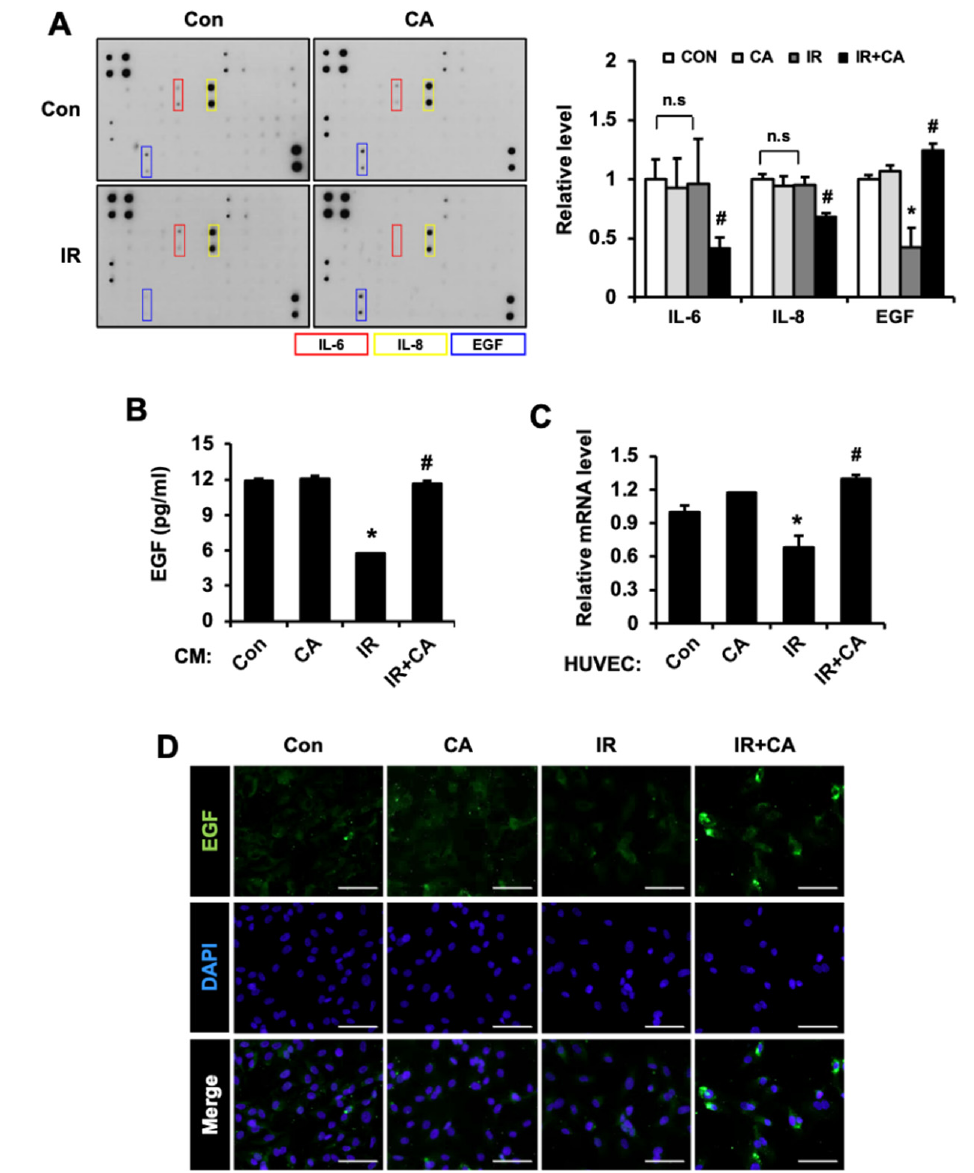
Figure 4. Centella asiatica accelerates epidermal growth factor production in irradiated endothelial cells. ( A ) The cytokine array was performed using the conditioned media of control (Con), irradiated (IR), CA-treated HUVECs (CA), and CA-treated irradiated HUVECs (IR + CA). The bar graph is shown as relative folds of interleukin (IL)-6, IL-8, and epidermal growth factor (EGF). ( B ) Secretion of EGF was quantified by ELISA. ( C ) The mRNA level of EGF was determined by qRT-PCR. ( D ) The EGF-positive cells were observed by confocal laser scanning microscope. Data are presented as the mean ± standard deviation of the mean; n = 3, * p < 0.05 compared to the Con group; # p < 0.05 compared to the IR group. Scale bars represent 50 µm. All data represent at least two independent experiments.